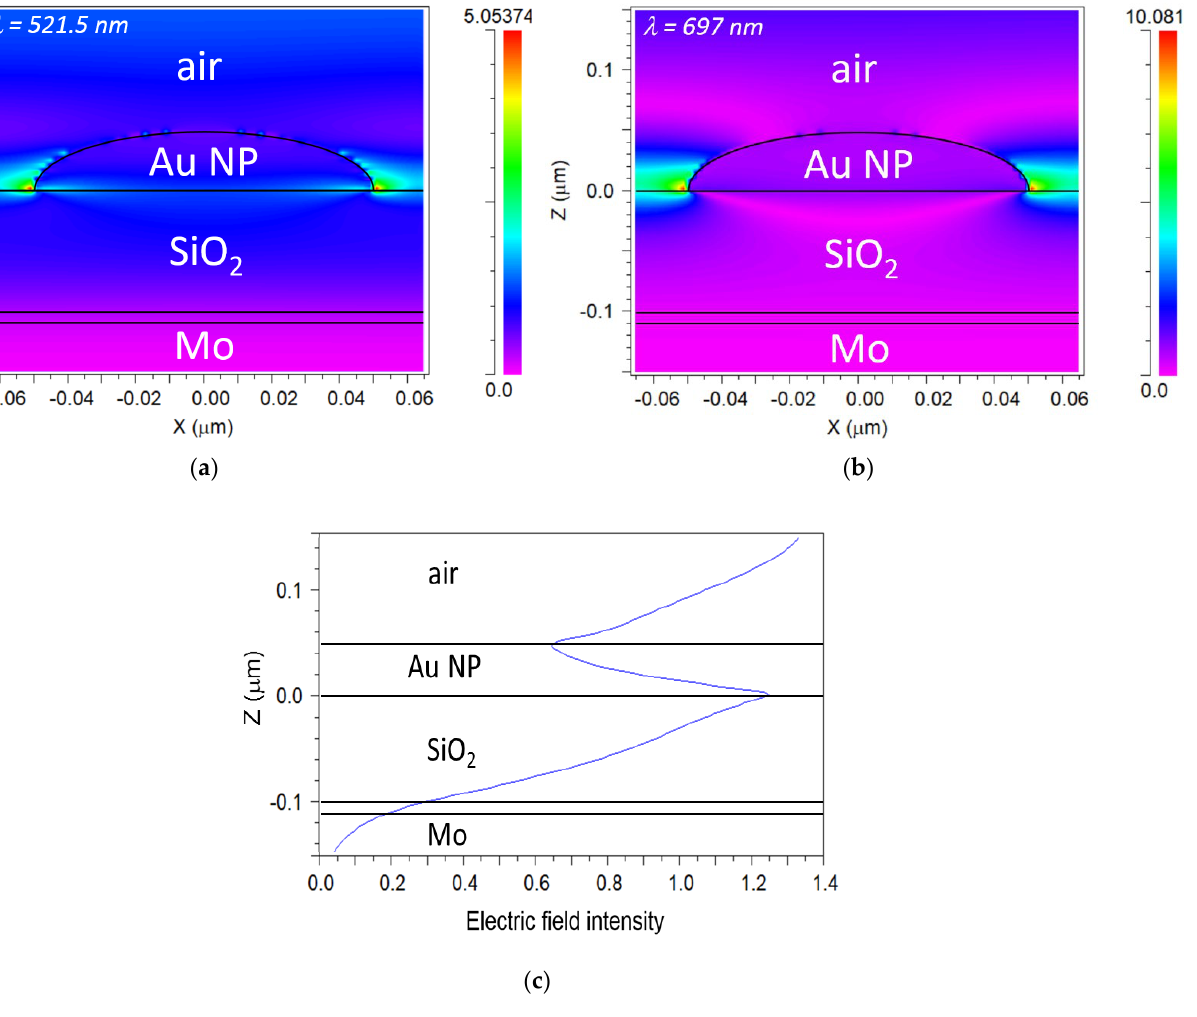
Figure 8. Calculated electric field (E x ) distribution at λ MIN = 521.5 nm ( a ) and λ MAX = 697 nm ( b ) of the modeled Au NP/SiO 2 /Ti/Mo configuration in the XZ plane; ( c ) x-cut along x = 0 of ( a ).